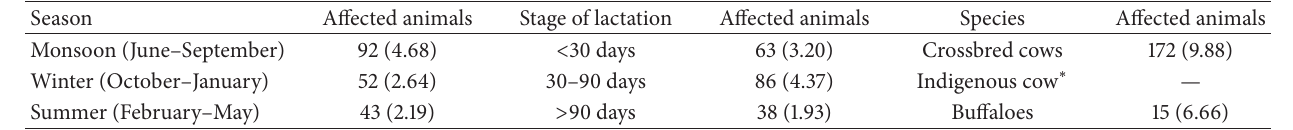
Table 2: Number of mastitis incidences over season, stage of lactation, and species of